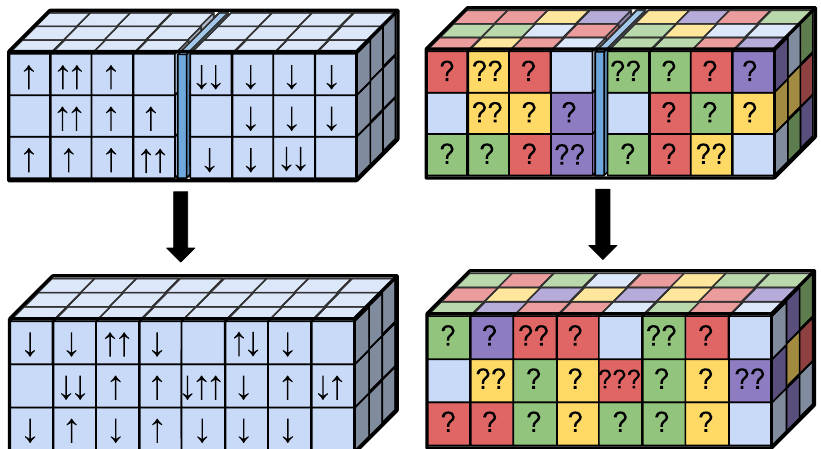
Fig. 2 Schematic of the quantum mixing process. Two diagrams representing the mixing of indistinguishable (bosonic) quantum gases from the perspective of the informed (left) and ignorant (right) observers. Initially, n spin — ↑ particles are found on the left and m spin — ↓ on the right. The particles are then allowed to mix while coupling to an external heat bath and work reservoir. The informed observer describes microstates via the number of particles in each cell, and their respective spins. The ignorant observer cannot tell the spins ’ states, but describes microstates (schematically depicted here by different colours) as superpositions of cell con fi gurations, determined by the decomposition